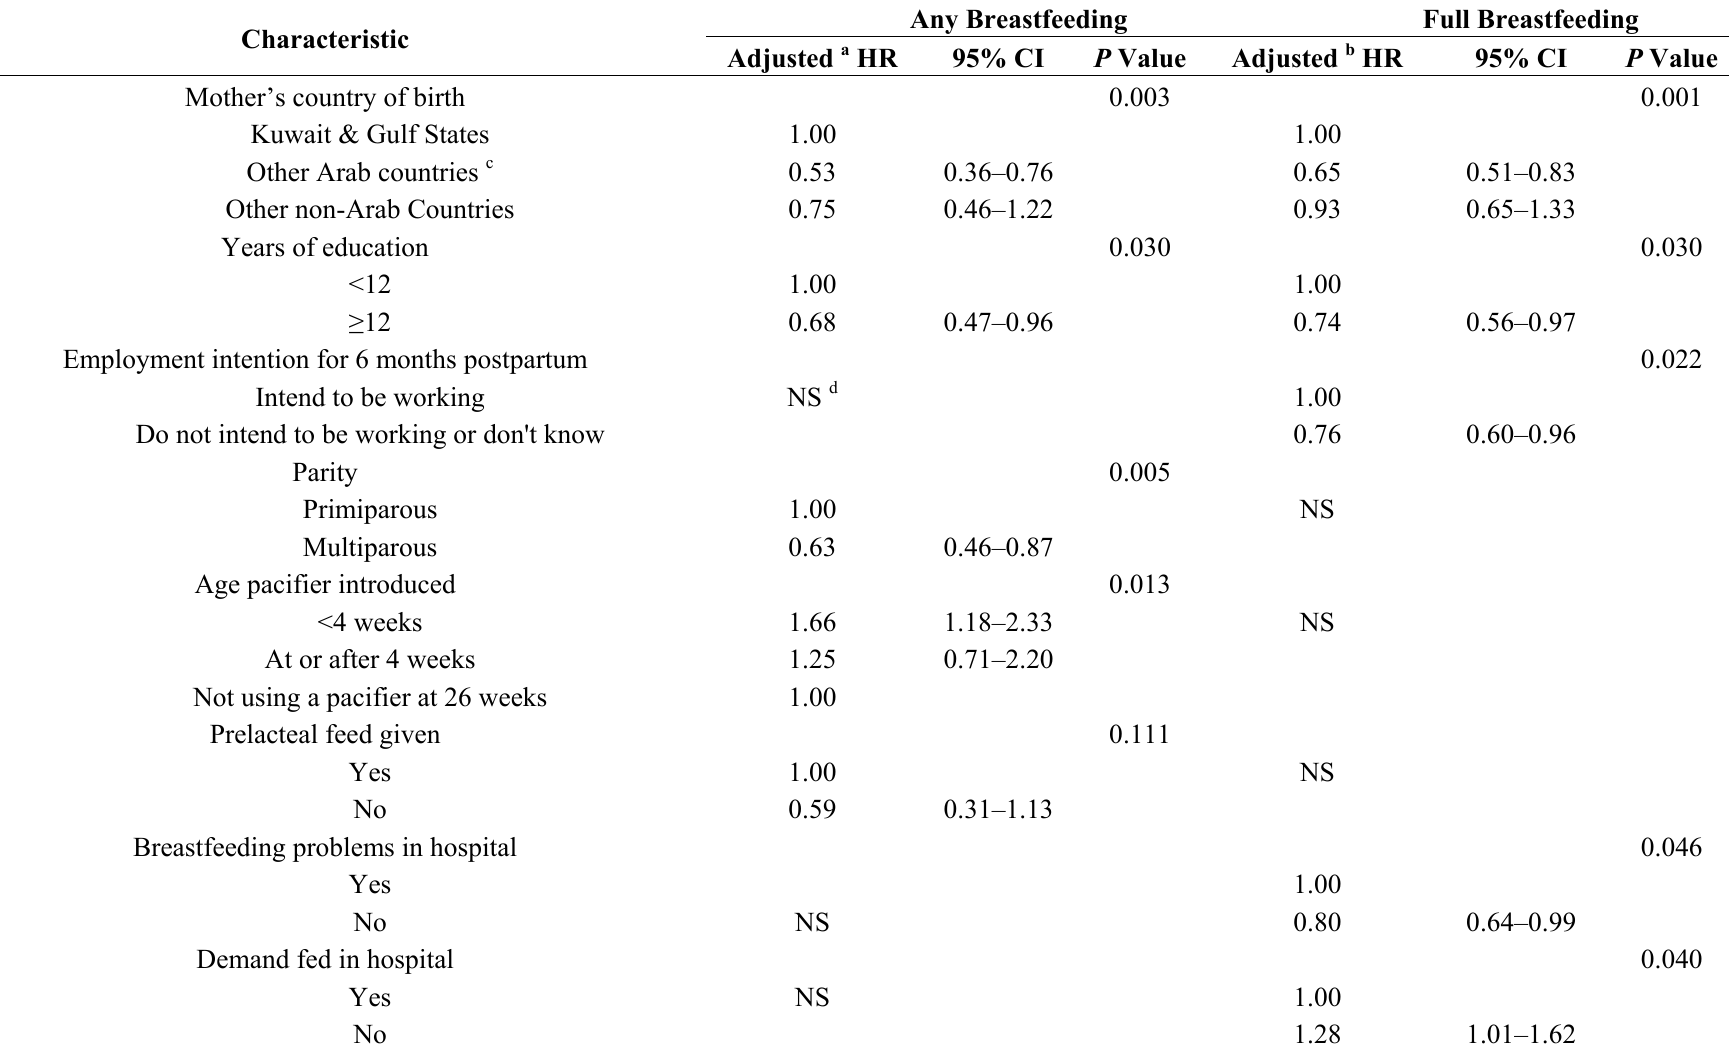
Table 3. Factors independently associated with the risk for discontinuing any or full breastfeeding in a cohort of mother-infant dyads followed to six months postpartum ( n =